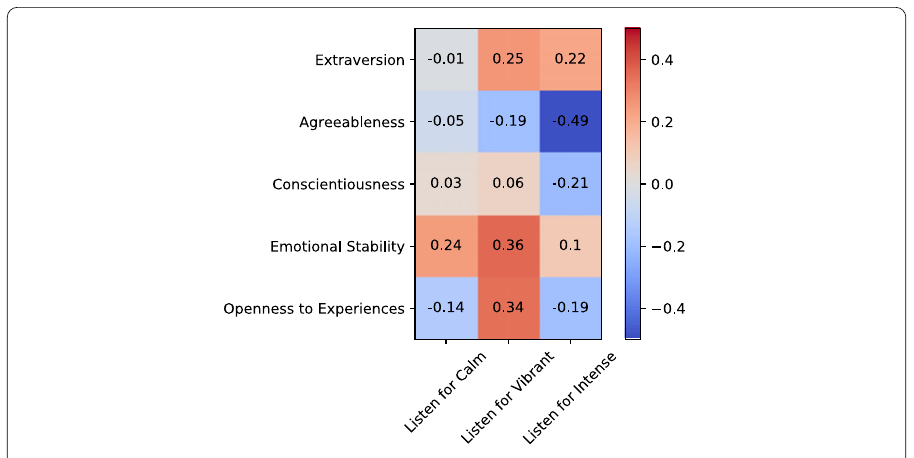
Figure 10 Correlation between our respondents’ five personality traits and their frequency in listening to music while engaging in one of the three music archetypes